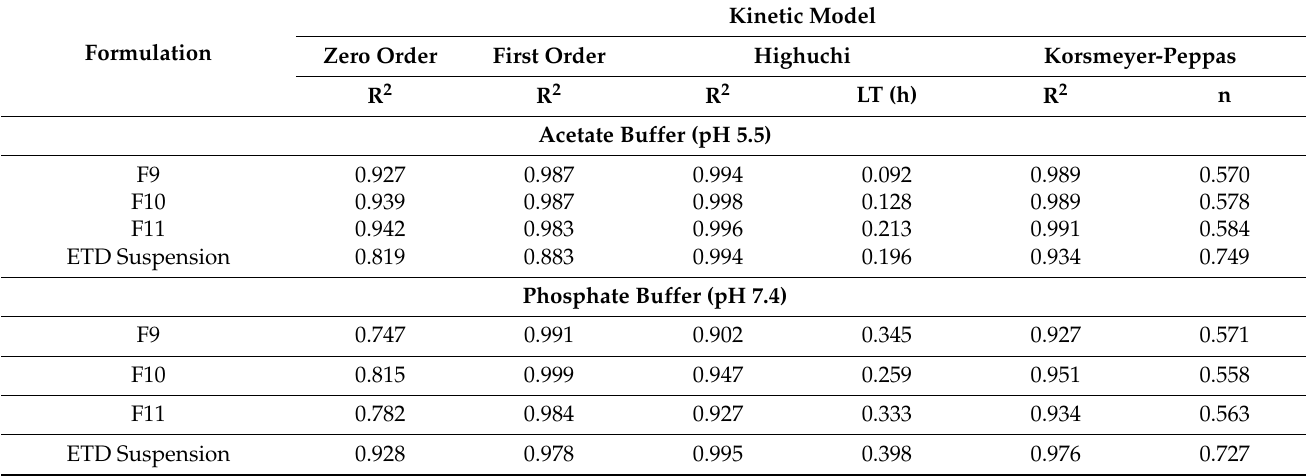
Table 4. Drug release kinetics for ETD-loaded NLC formulations in acetate (pH 5.5) and phosphate (pH 7.4) buffers, with 1% Tween